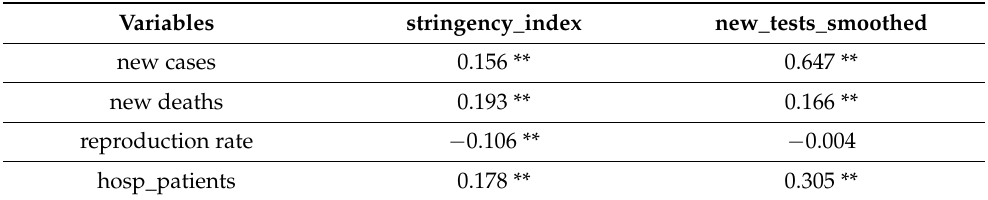
Table 6. Spearman’s r s correlation indexes calculated between variables indicating restrictions and intensity of the disease in